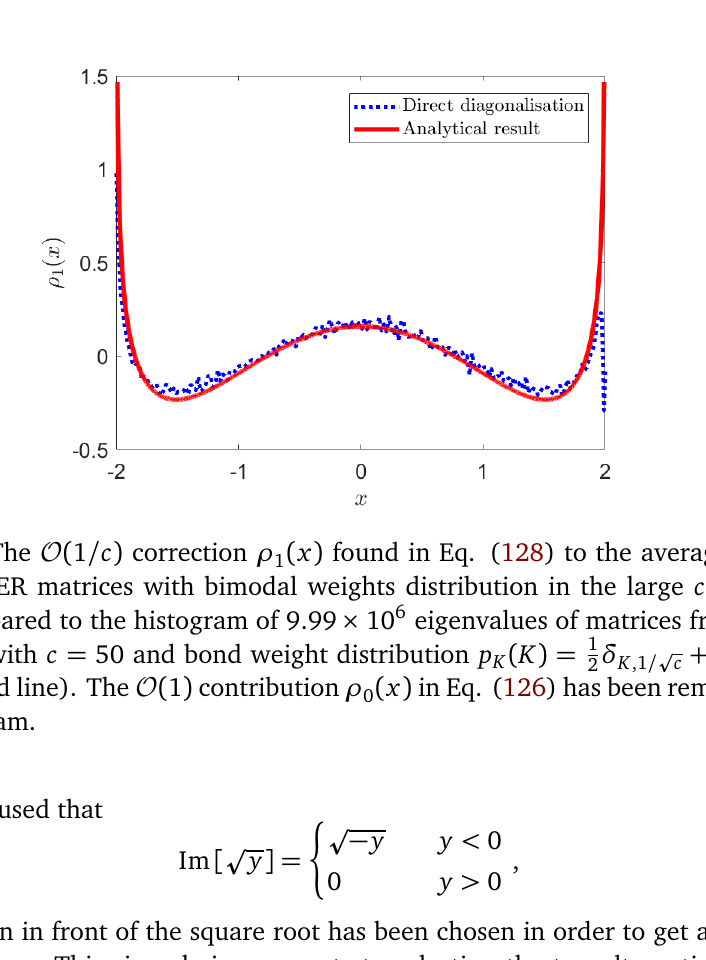
Figure 2: The O ( 1 / c ) correction ρ density of ER matrices with bimodal weights distribution in the large c limit (red line), compared to the histogram of 9.99 × 10 6 eigenvalues of matrices from the ER ensemble with c = 50 and bond weight distribution p (blue dotted line). The O ( 1 ) contribution ρ the